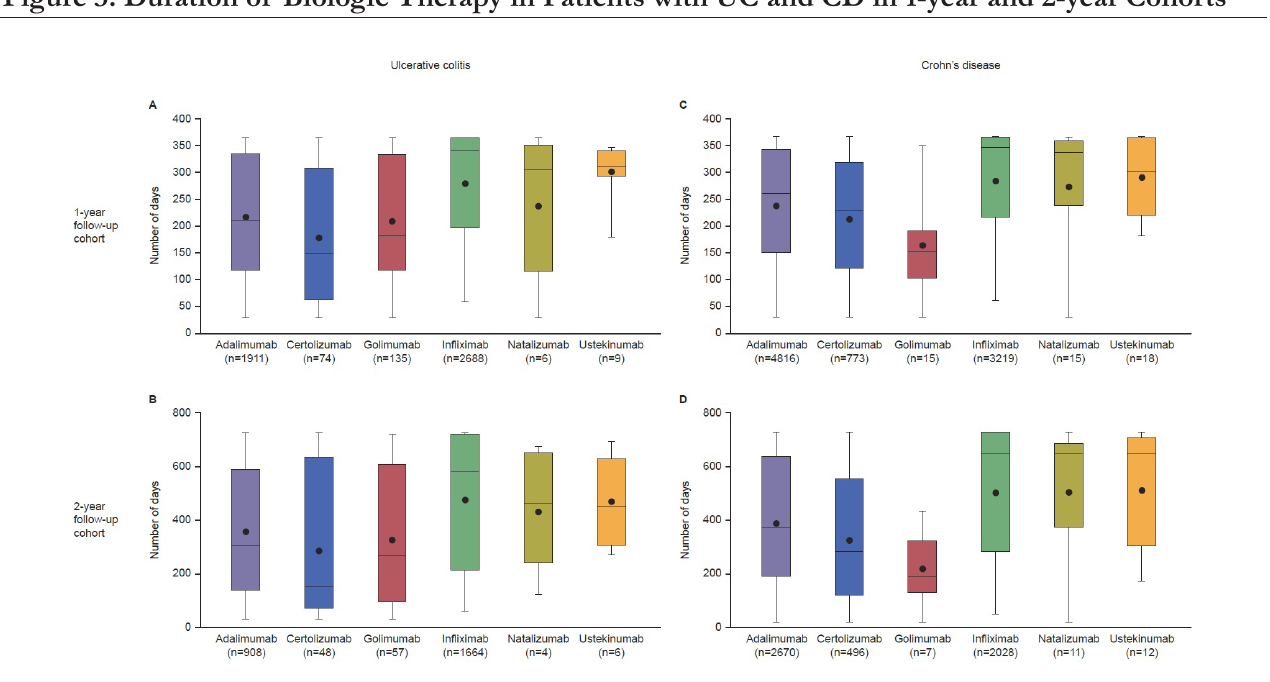
Figure 3. Duration of Biologic Therapy in Patients with UC and CD in 1-year and 2-year Cohorts